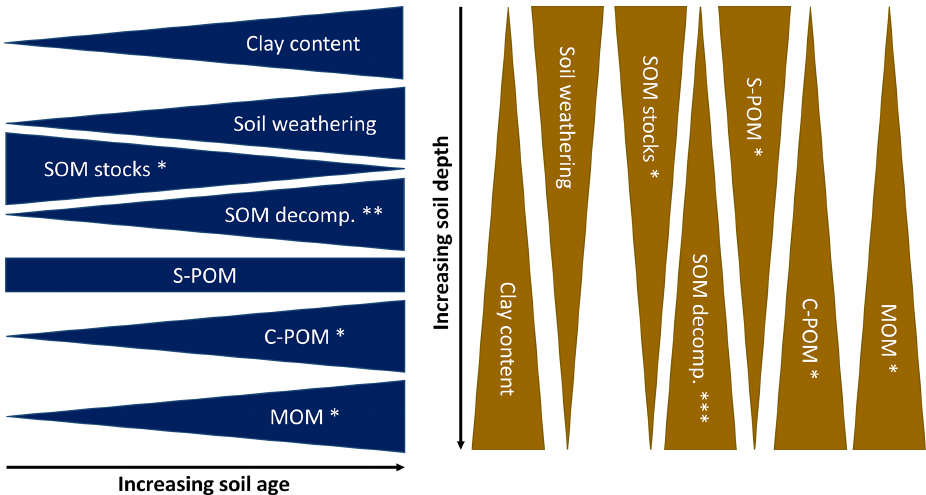
Figure 5. Conceptual model explaining the influence of soil development with increasing soil age and depth on mineralogy and texture based on our findings. These properties (i.e. Fe total :Si total , Fe DCB ) may then drive the dynamics of SOM stocks, properties, and composition. SOM stocks reflect the total C stock, SOM decomposition proxies include δ 13 C, δ 15 N, and the C:N ratio, and the signals of the selected DRIFTS peak areas are represented individually. Soil weathering proxies and clay content were not tested since only one value per soil age and depth was available ( n = 10). SOM decomposition proxies and peak areas were tested by a two-way ANOVA ( n = 30) with Tukey’s HSD as the post hoc test ( p< 0 . 05): ∗ shows significant trends, ∗∗ significant trends for C:N and δ 15 N but not for δ 13 C, and ∗∗∗ significant trends for C:N and δ 13 C but not for δ 15 N. The outcomes of the ANOVA are visualized in Figs. 3 and 4 and the values of soil geochemistry in Table